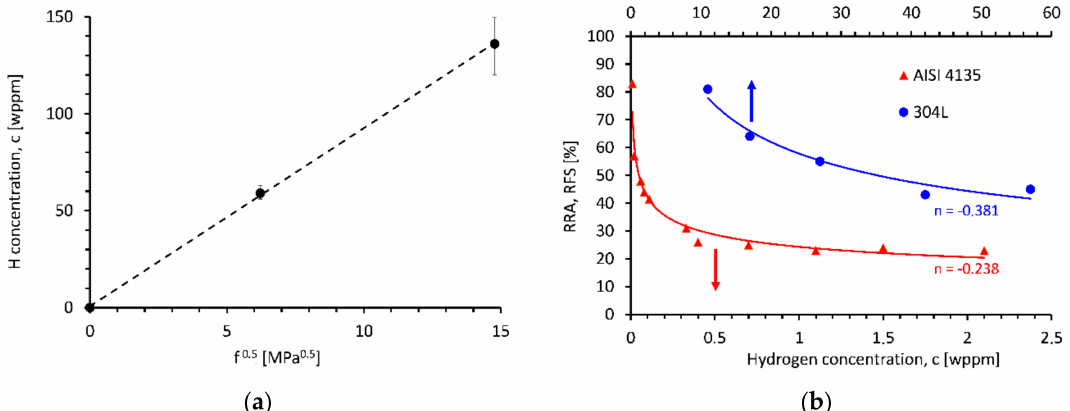
Figure 5. ( a ) Fugacity-modified Sievert’s law with data from [50,51], ( b ) RRA of 304 L austenitic stainless steel [5] and relative fracture stress (RFS) of AISI 4135 martensitic high strength steel [7] pre-charged with hydrogen as a function of hydrogen